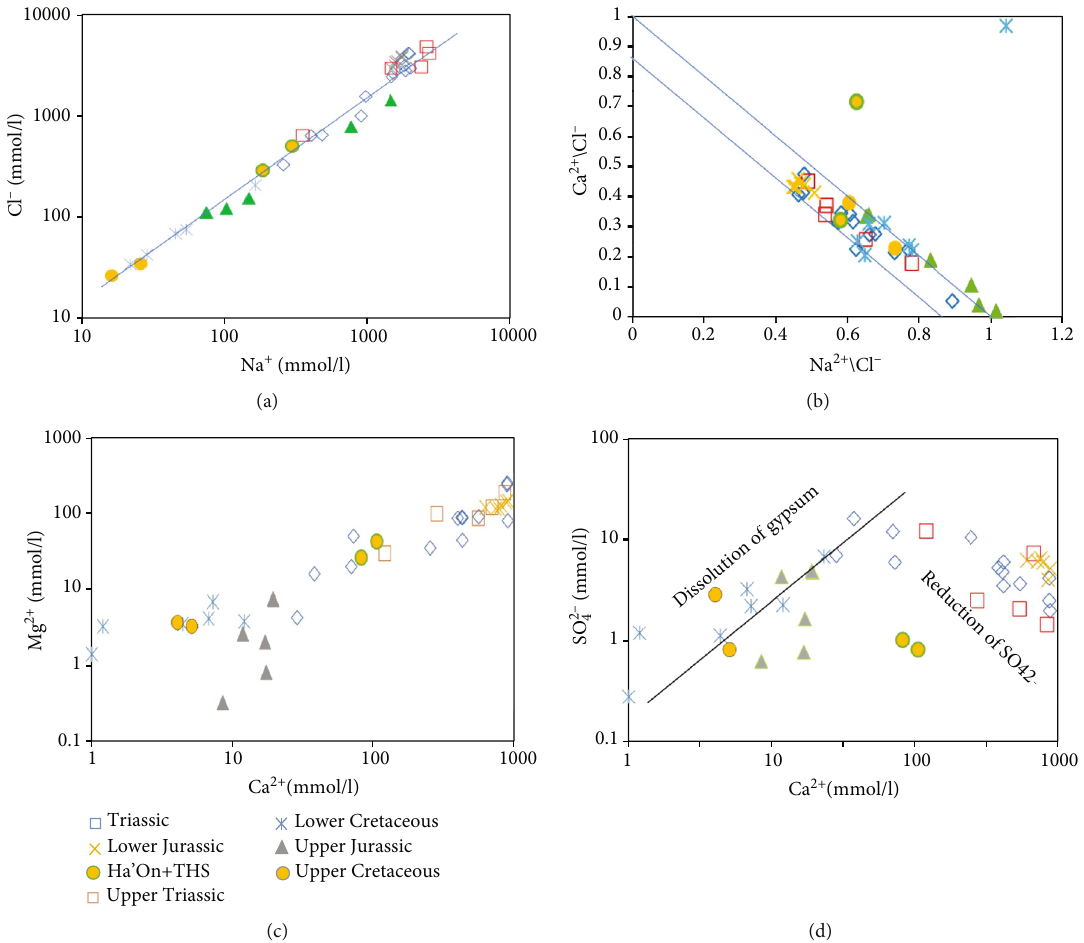
Figure 6: Cross plots of elements and element ratios indicating mineralogical processes. (a) Dissolution of halite or dilution of brine with freshwater. (b) The slope of the Mg 2+ vs. Ca 2+ plot with 0.17 is in the range of equilibria with dolomite. (c) Albitization of plagioclase. (d) Cross plots of Ca 2+ vs. SO 42- reveal that three di ff erent trends: (i) dissolution of gypsum, (ii) sulfate dissolution, and (iii) bacterial sulfate reduction. Ratios are based on